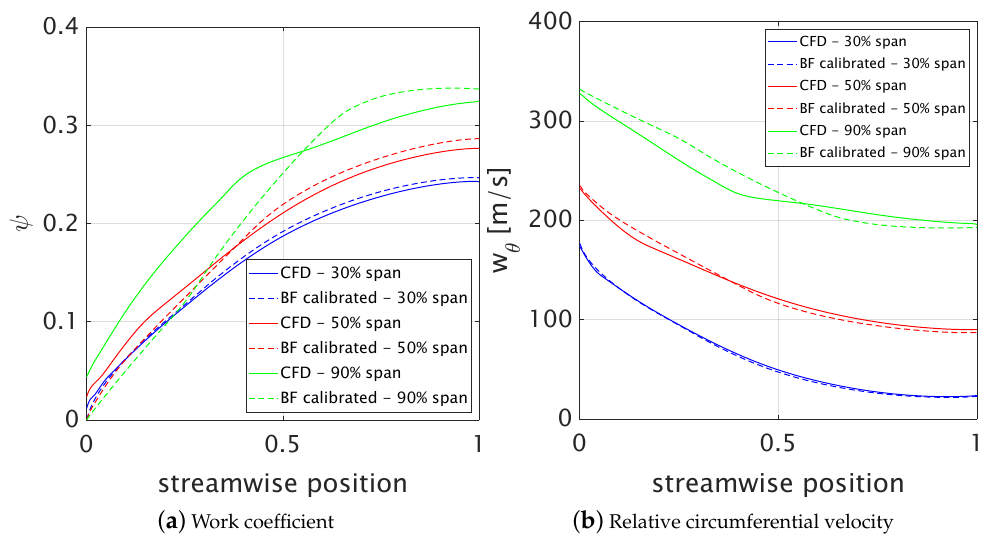
Figure 15. Streamwise profiles at near stall for reference CFD solution and calibrated BFM.